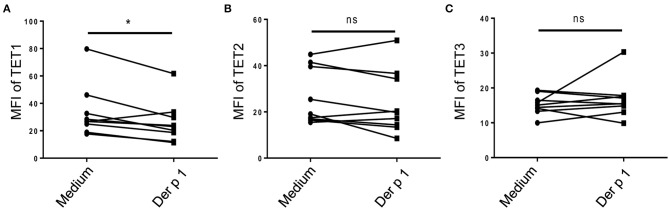
Allergen stimulation decreased TET1 in atopic monocyte-derived DCs from AR patients. Immature moDCs (day 5) induced from the peripheral blood monocytes of house dust mite (HDM)-allergic AR patients were exposed to Der p1 for 48 h and the expression of TET family (A showed TET1, B showed TET2, and C showed TET3) were assessed by flow cytometry. Paired t-tests were conducted to analyze the data. *p < 0.05 (n = 8).